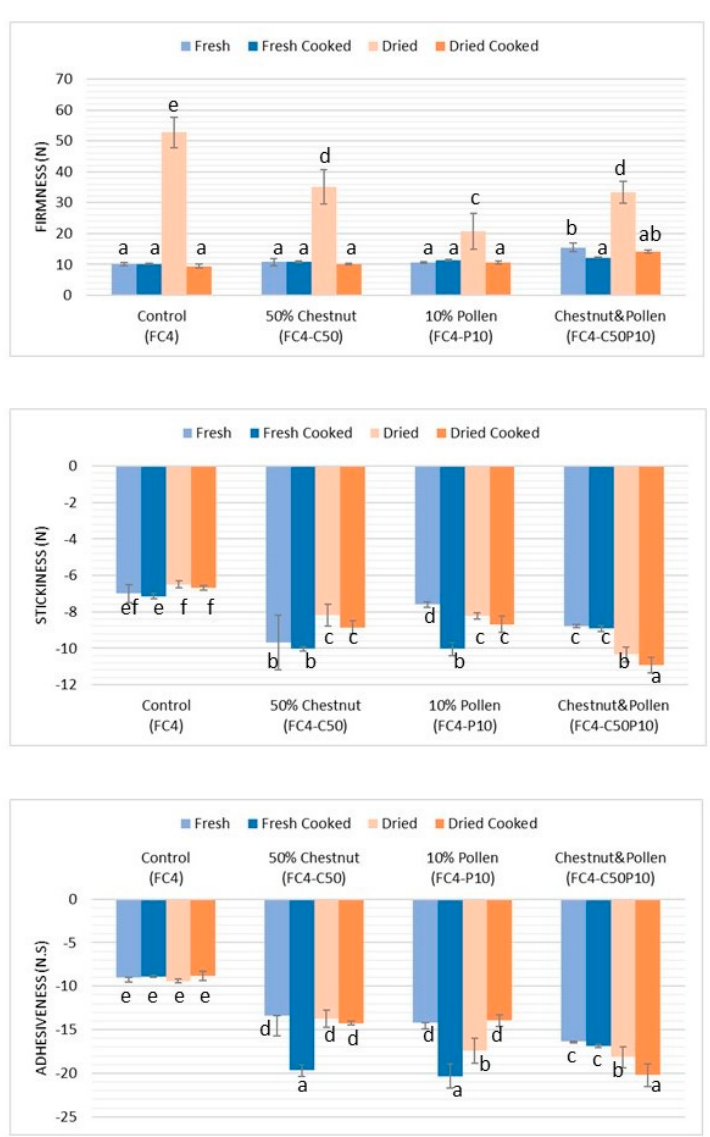
Figure 7. Textural parameters of the pasta formulations developed. Statistical analysis: ANOVA with a post-hoc Tukey’s test ( p < 0.05); bars with the same letter are not statistically different.